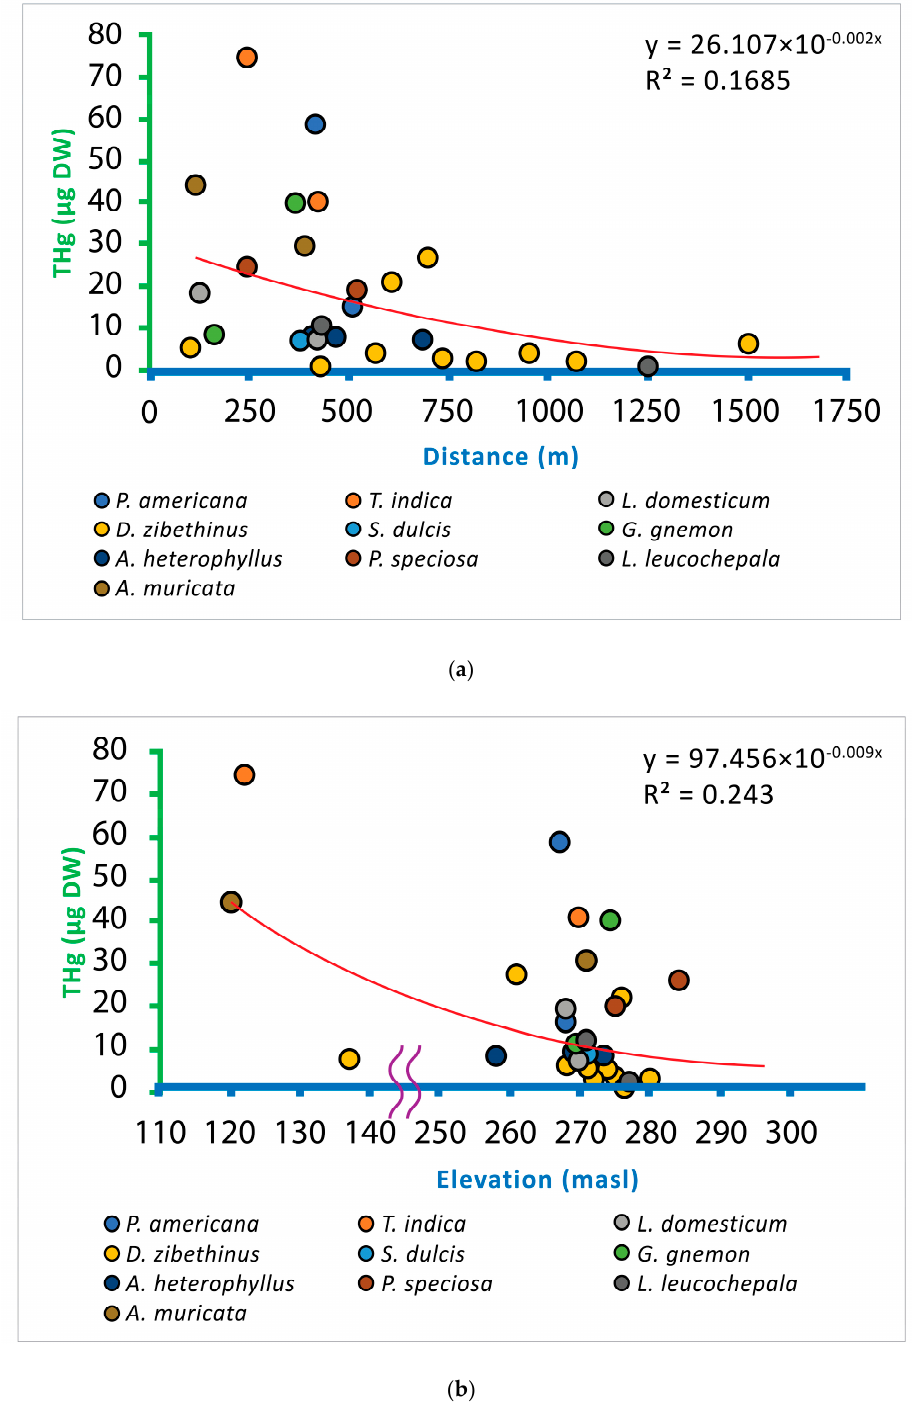
Figure 4. Distribution of the MPTS plant correlations: ( a ) Distribution of the distribution patterns on distance and THg variables; ( b ) Distribution of the distribution pattern on the variables of height and